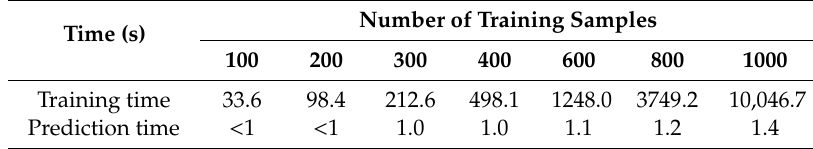
Table 5. The computation time of PSO–LWPLS varies with the number of training